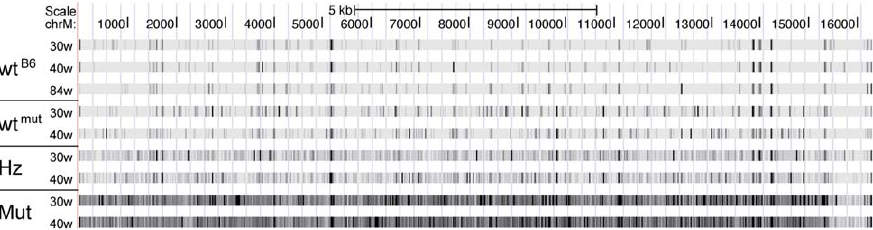
Figure 2. Corrected mutational frequencies viewed in the UCSC genome browser. The scale ranges from low mutation frequencies (light colors) to high mutation frequencies (black). (Abbreviations: wt B6 =C57Bl/6N animal, wt mut = wildtype sibling of the mtDNA mutator mouse, Hz= heterozygous sibling of the mtDNA mutator mouse, Mut = mtDNA mutator mouse, 30w & 40w =30 and 40 weeks of age, respectively).